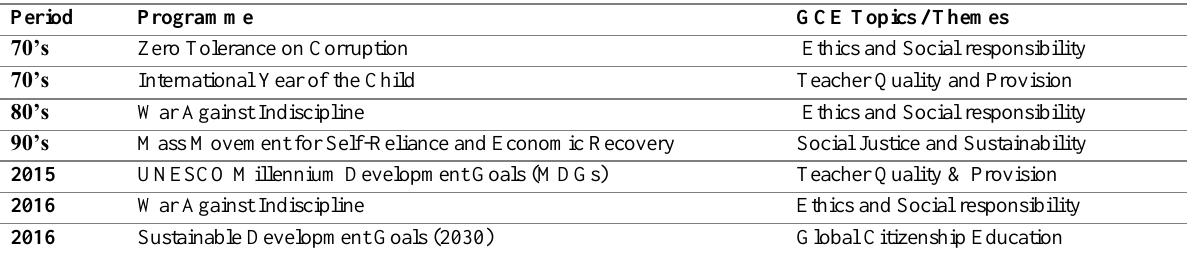
Table 2: National Citizenship Orientation Programmes in